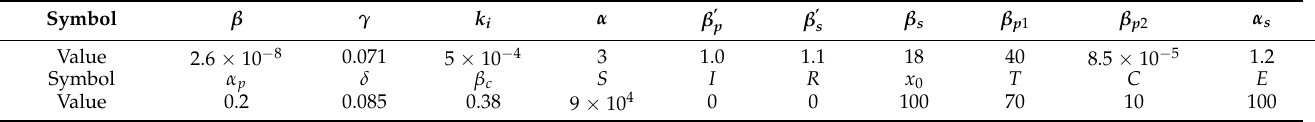
Table 1. Settings of model parameters and initial states and boundaries.